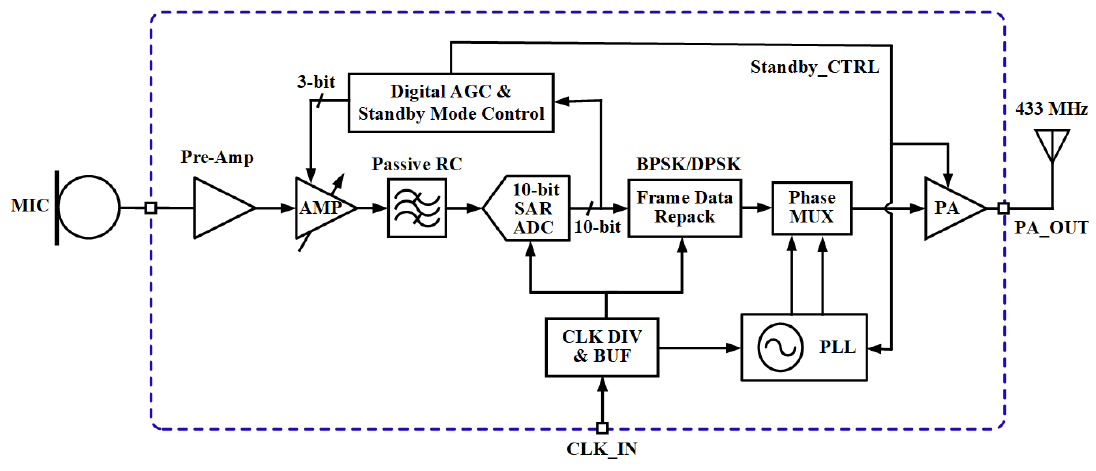
Figure 1. Block diagram of the proposed acoustic sensing platform.